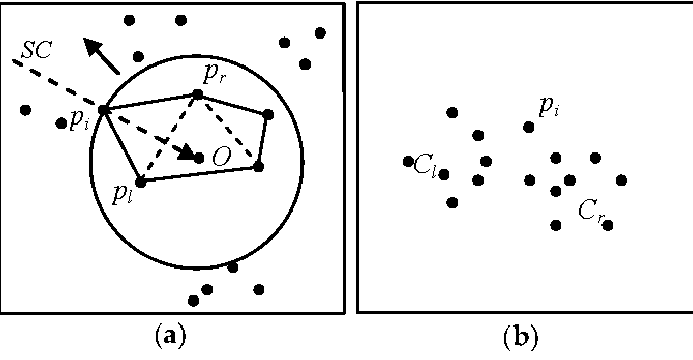
Figure 8. Adaptive spatial clustering (ASC) algorithm cluster basics with the following steps: ( a ) sweeping of the points; and ( b ) obtaining two clusters.